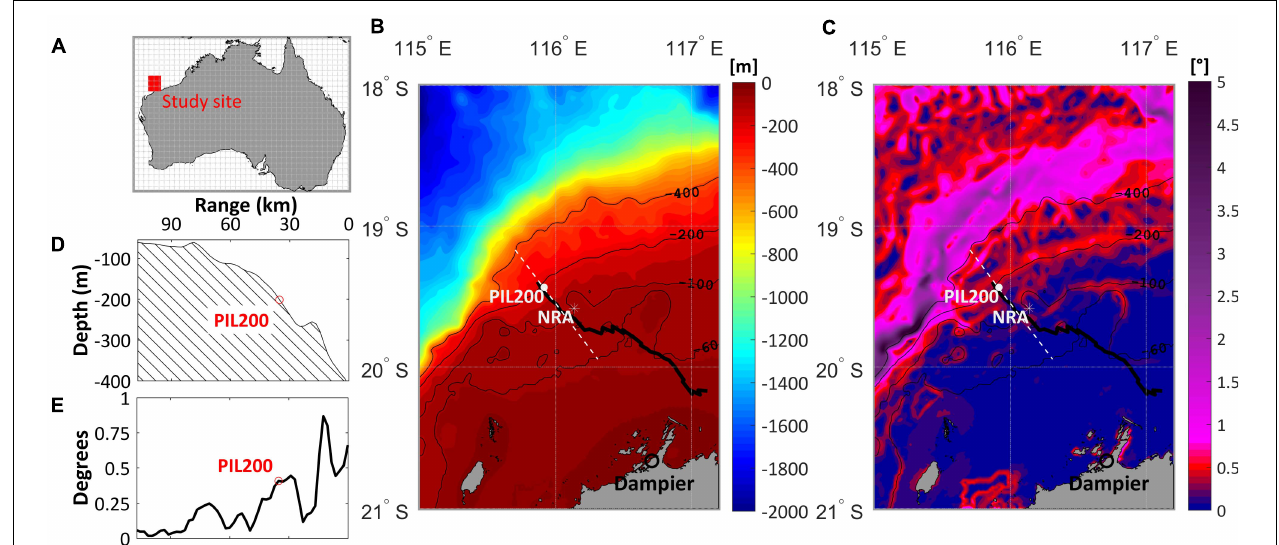
FIGURE 1 | (A) The study site within the Australian North West Shelf. (B) Bathymetry, mooring station (PIL200), glider track (black line), and the North Ranking-A (NRA). (C) The slope, (D) bathymetric cross-section and (E) the related cross-sectional slope (in